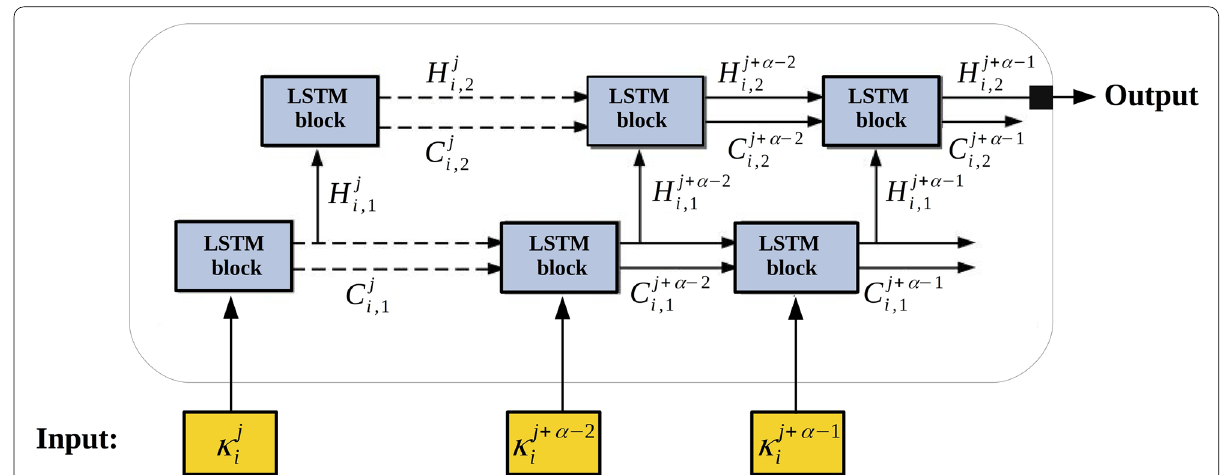
Fig. 6 The architecture of the LSTM network we used in our anomaly detection